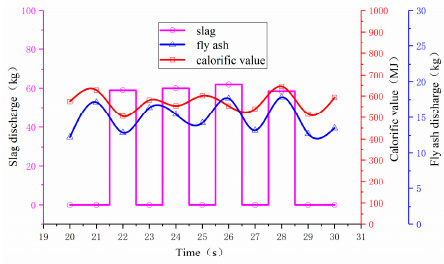
Figure 24. Dynamic changes of fly ash, slag, and calorific value (20~30 s).